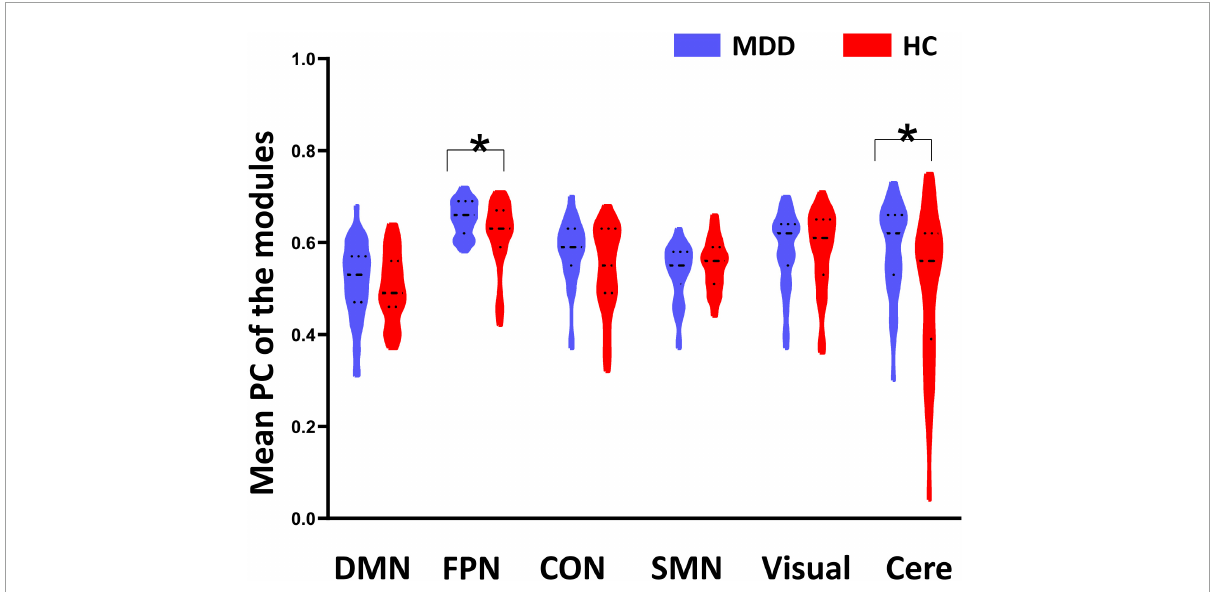
FIGURE2 Between-group differences of mean participant coefficient (PC). Major depressive disorder (MDD) patients showed significantly higher PC on the fronto-parietal network (FPN) and cerebellum (Cere) than the healthy controls (HC). *Indicates p < 0.05.